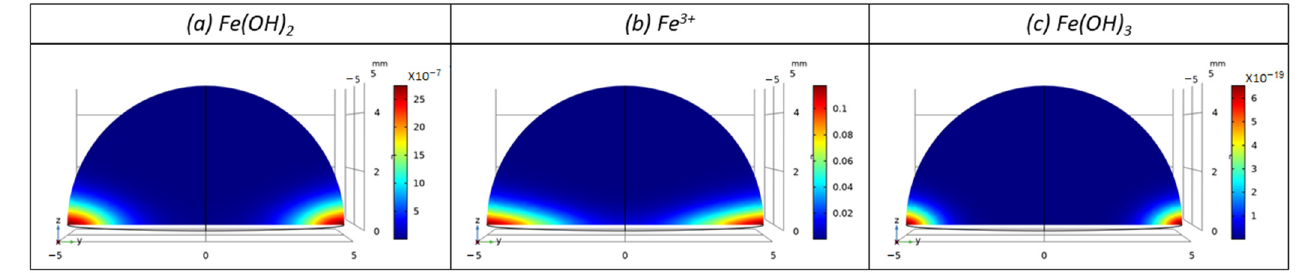
Figure 9. Concentration profiles of species involved in the Evans’s drop reactions, namely ( a ) ferrous hydroxide, Fe(OH) 2 , ( b ) ferric ions, Fe 3+ and ( c ) ferric hydroxide, Fe(OH) 3 .